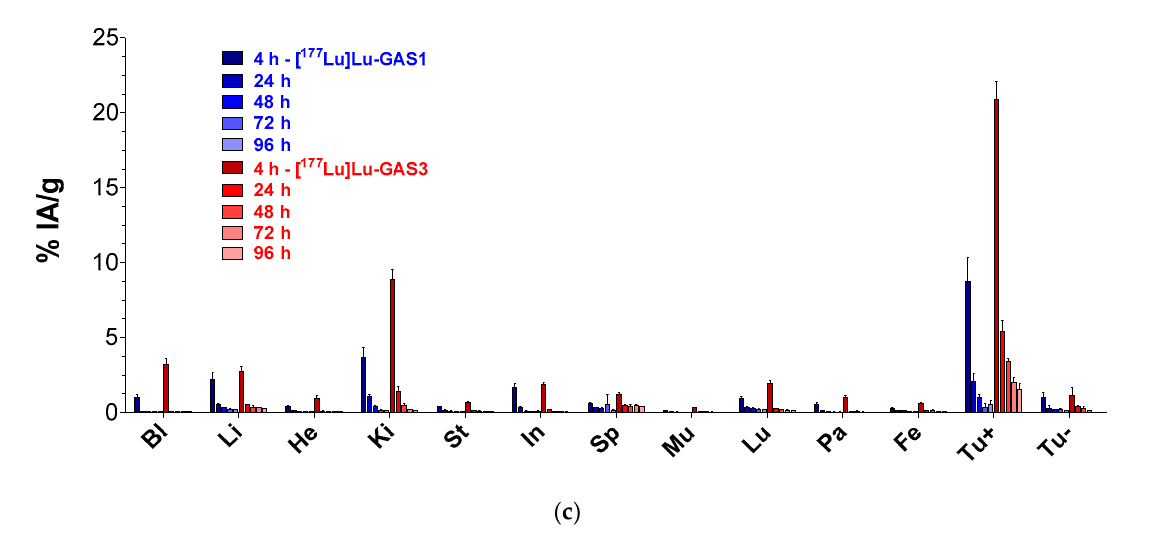
Figure 4. Comparative biodistribution data in SCID mice bearing twin HEK293-CCK 2i4sv R and wtHEK293 tumors in their flanks expressed as % IA/g tissue (mean ± SD, n = 4) for ( a ) [ 67 Ga]Ga- GAS1/2/3, ( b ) [ 111 In]In-GAS1/2/3 and ( c ) [ 177 Lu]Lu-GAS1/3; Bl: blood, Li: liver, He: heart, Ki: kidneys, St: stomach, In: intestines, Sp: spleen, Mu: muscle, Lu: lungs, Pa: pancreas, Fe: femur, Tu+/ − : HEK293-CCK 2i4sv R/wtHEK293 tumor.